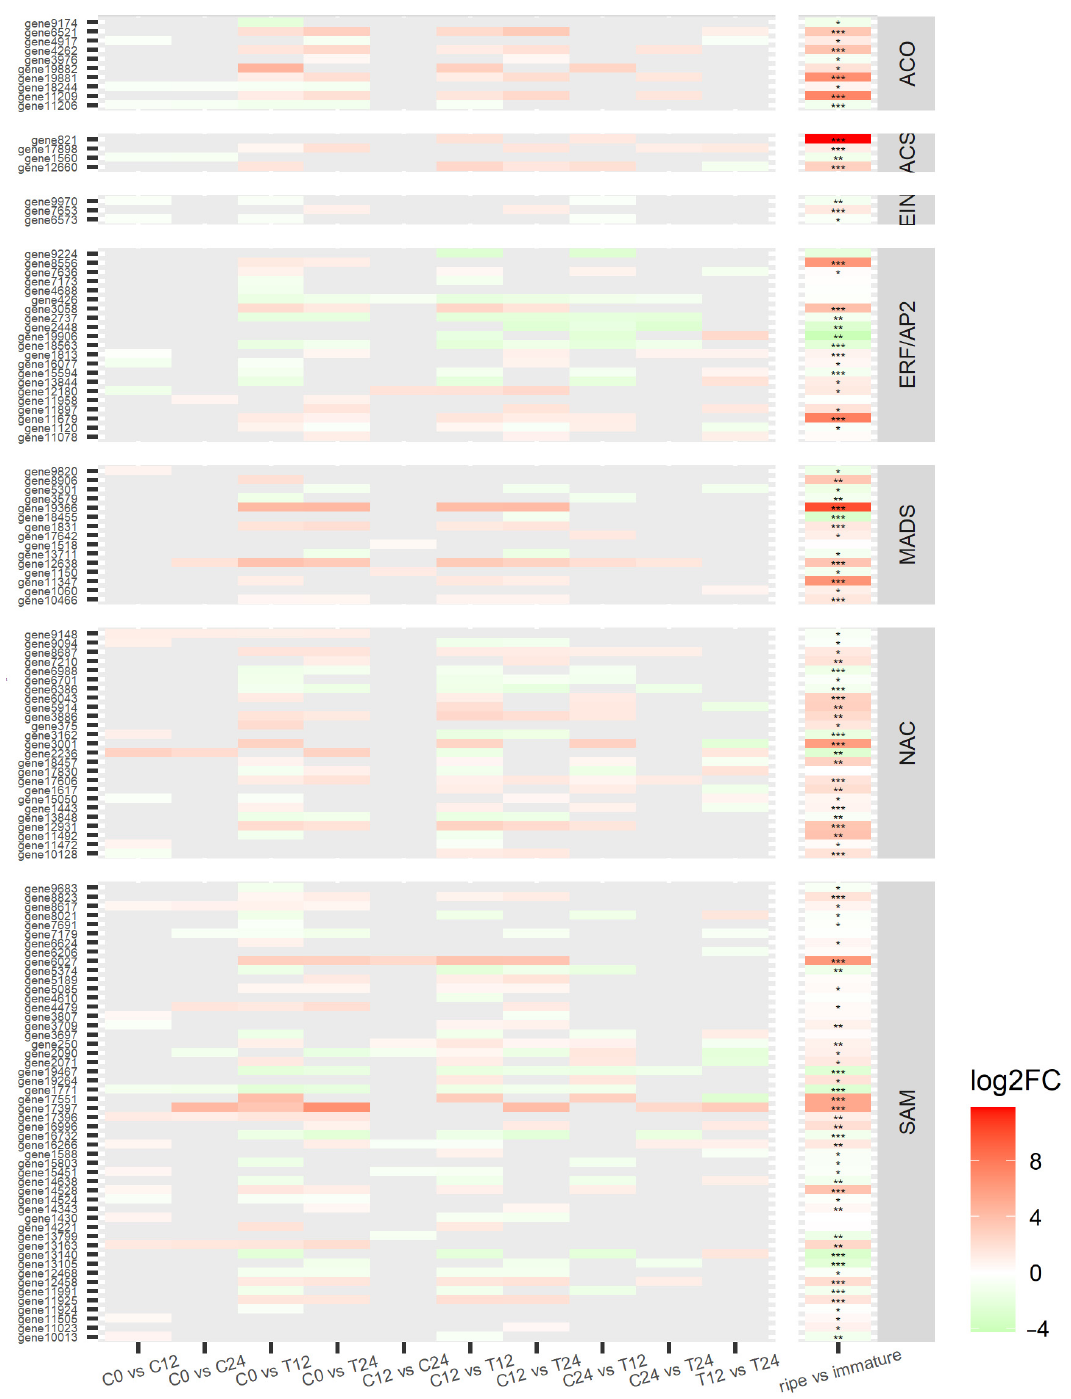
Figure 4. Ethylene-related genes’ expression. Colors represent the difference in expression of the latter group in relation to the first. The first set of columns is the comparisons between samples of the performed RNA-seq, and the last column refers to the differential meta-analysis. Genes are grouped by their coding enzymes: ACO, 1-aminocyclopropane-1- carboxylate oxidase; ACS, 1-aminocyclopropane-1-carboxylate synthase; EIN, ethylene-insensitive protein; ERF/AP2, ethylene-responsive transcription factor; MADS, agamous-like MADS-box protein; NAC, NAC domain-containing protein; and SAM, S-adenosyl-L-methionine-dependent methyltransferases superfamily protein. Asterisks represent p -adjusted values (* p < 0.05; ** p < 0.01; *** p < 0.001); no asterisk means p -adj > 0.05. Samples are identified as C (control) or T (treated) followed by the time